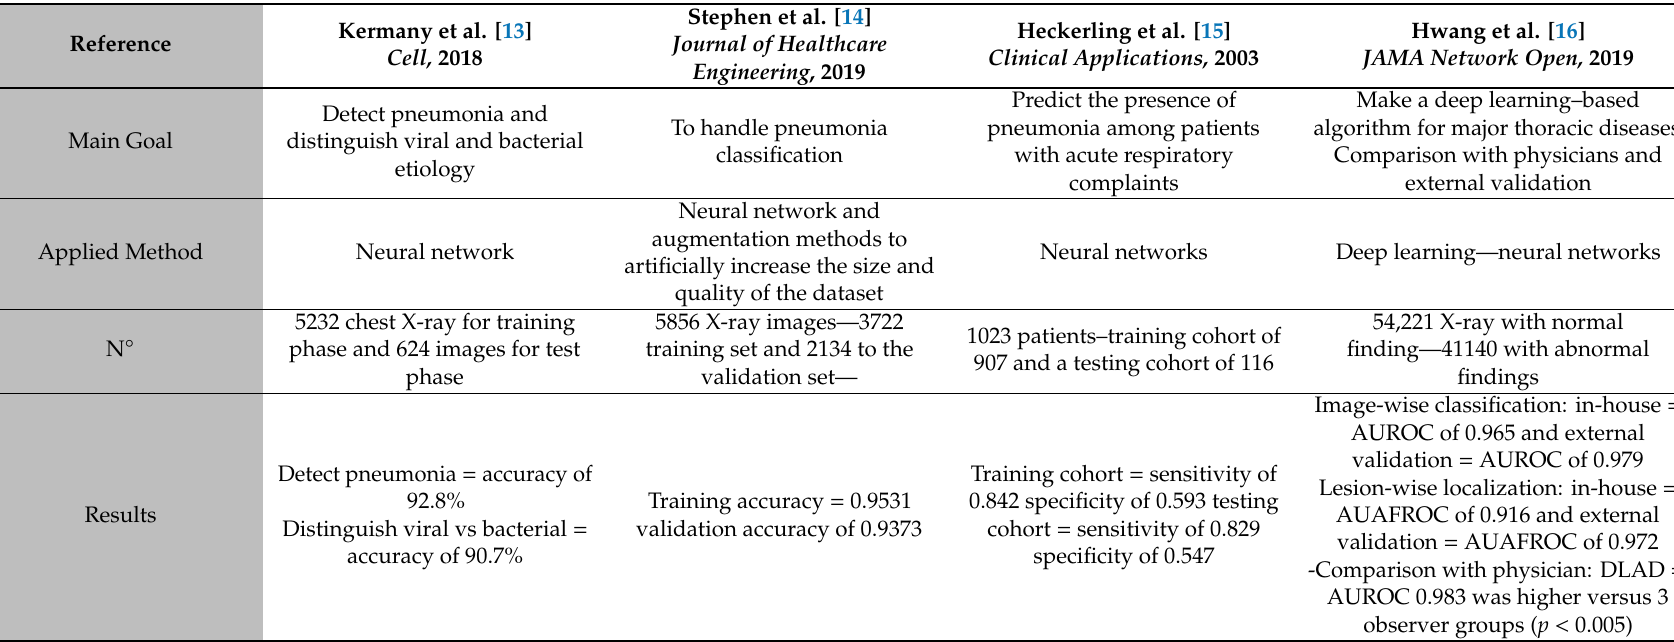
Table 1. Recently published AI approaches being undertaken to support clinical decision-making processes in